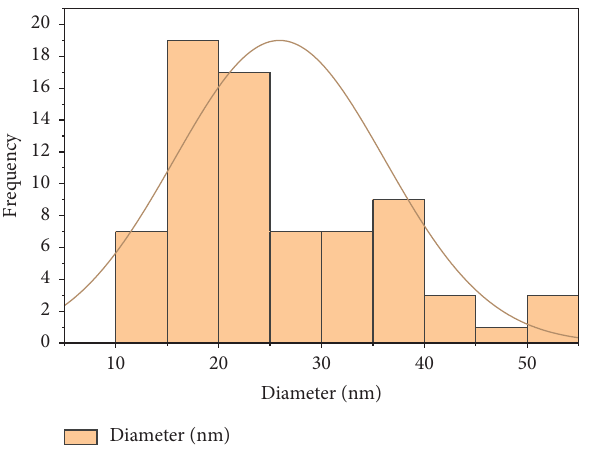
Figure 5: Size distributions of HAp NPs.